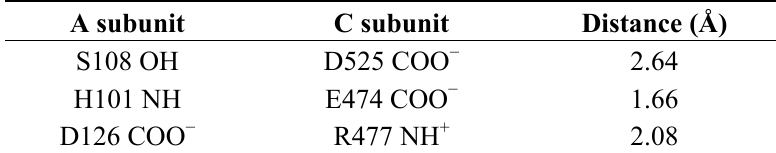
Table 2. The interatomic contacts between A and C subunit.